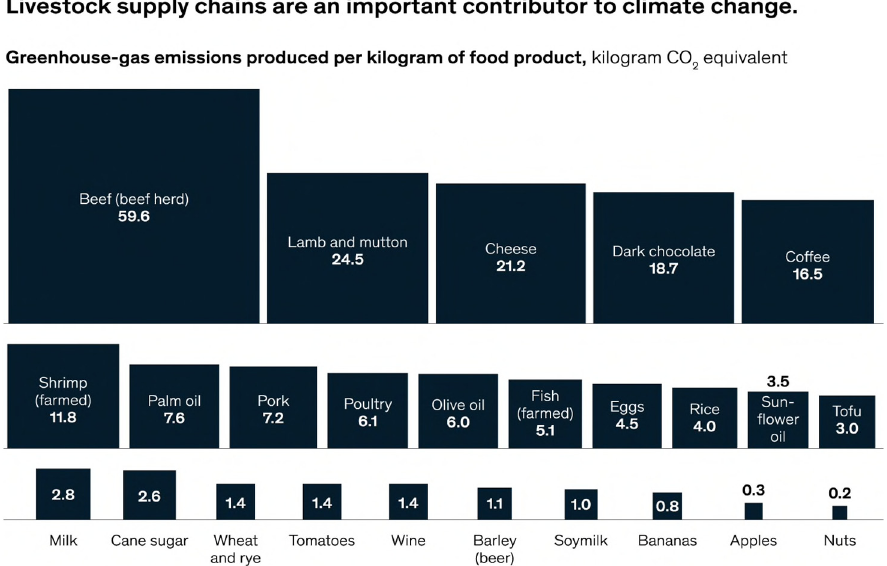
Figure 4. GHG emissions released in the environment to produce different kind of food (Reprinted with permission from Doer and Narisetti (2021). 2021 McKinsey Global Publishing [4]).